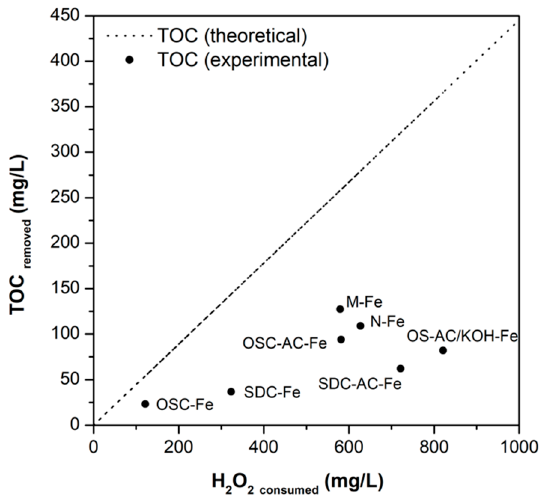
Figure 13. H 2 O 2 consumed vs. experimental (and theoretical) TOC removals for each catalyst.